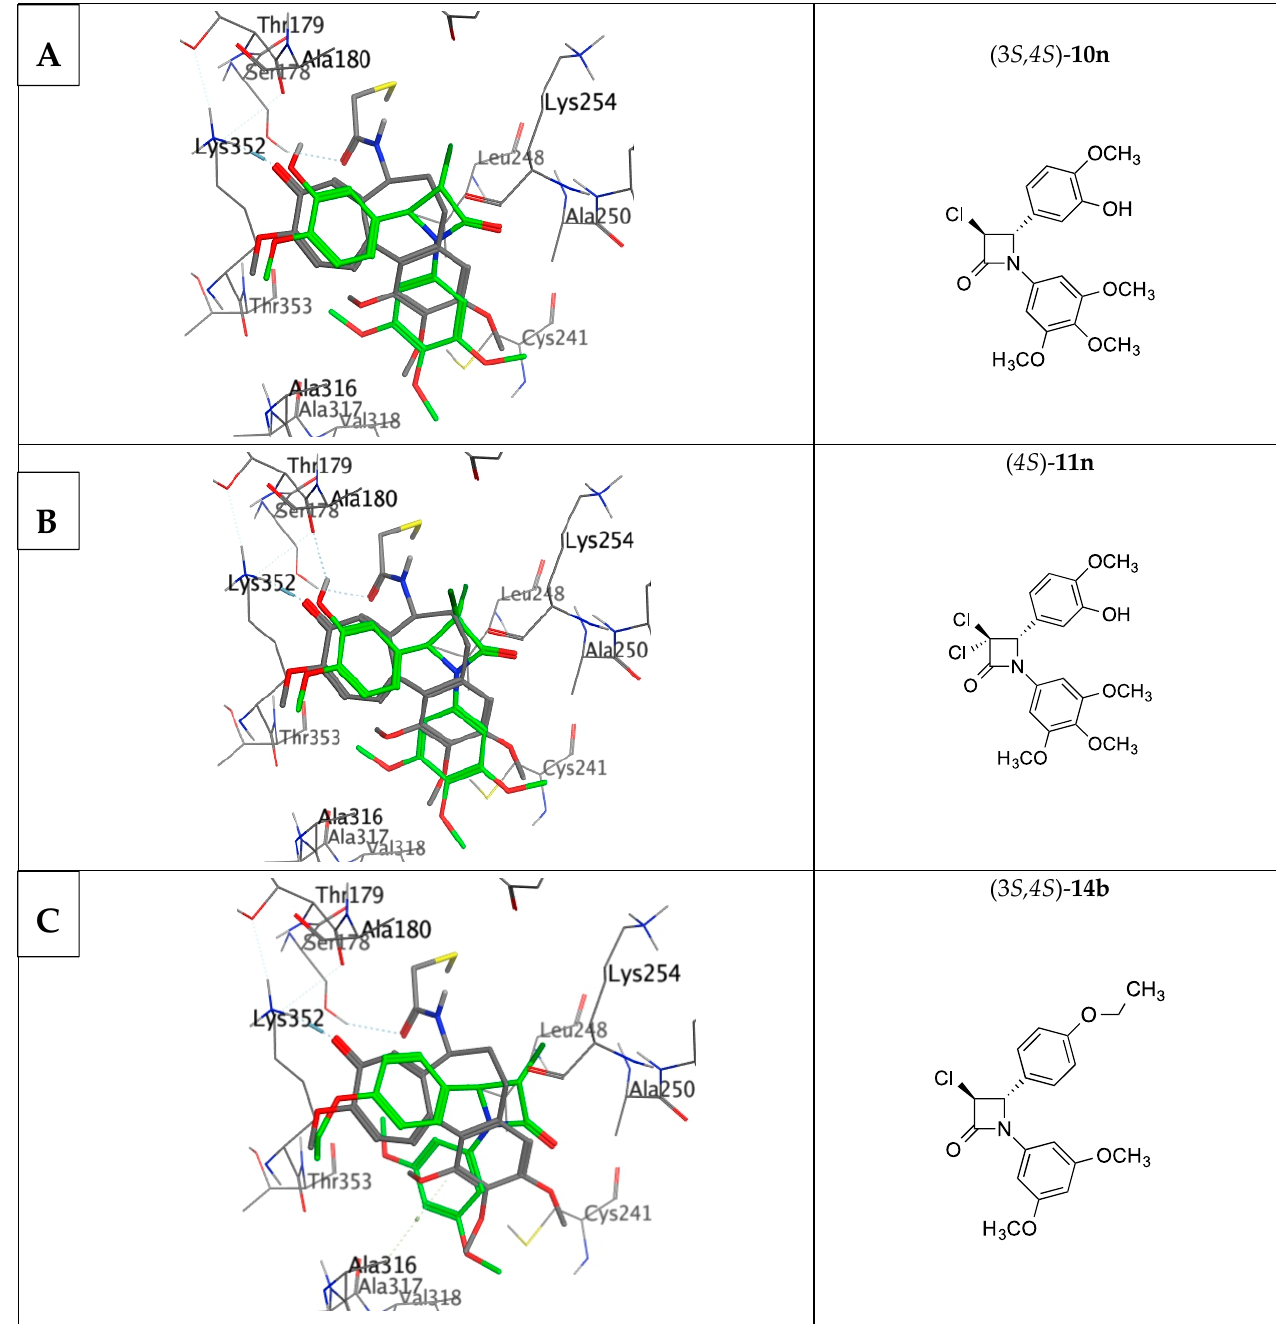
Figure 11. Overlay of the X-ray structure of tubulin co-crystallised with DAMA-colchicine (PDB entry 1SA0) on the best ranked docked poses of the S enantiomers of the three studied beta-lactams: ( A ) 10n , ( B ) 11n and ( C ) 14b . Ligands are rendered as tube and amino acids as line. Tubulin amino acids and DAMA-colchicine are coloured by atom type: carbon = grey, hydrogen = white, oxygen = red, nitrogen = blue, sulphur = yellow, bromine = dark red, chlorine = dark green. The beta-lactams are depicted with a green backbone. The atoms are coloured by element type, Key amino acid residues are labelled, and multiple residues are hidden to enable a clearer view.